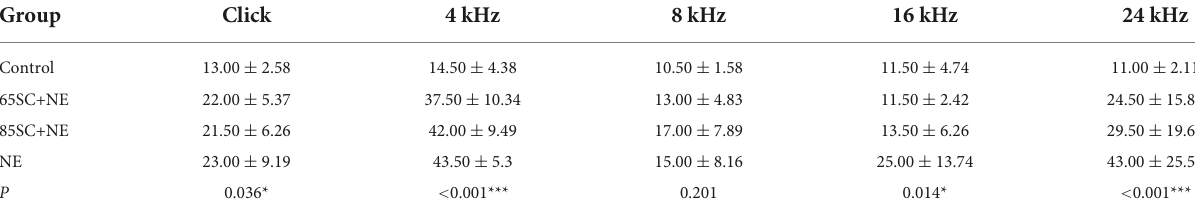
TABLE 3 Auditory brainstem response (ABR) thresholds for each group at the moment of noise exposure (D3) (dB SPL). Group